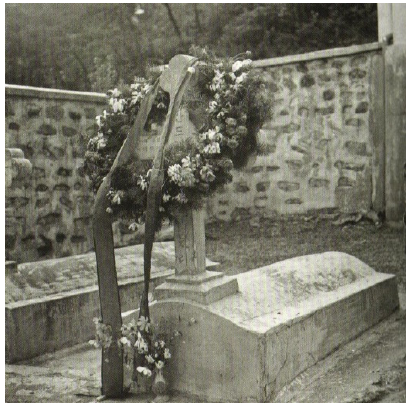
Figure 15. Graves of Father Kang Do-Young and Father Kim Dae-Geon; image dated September 1965 [source: Father Mark Kang Do-Young’s Collection of Letters , p. 584].